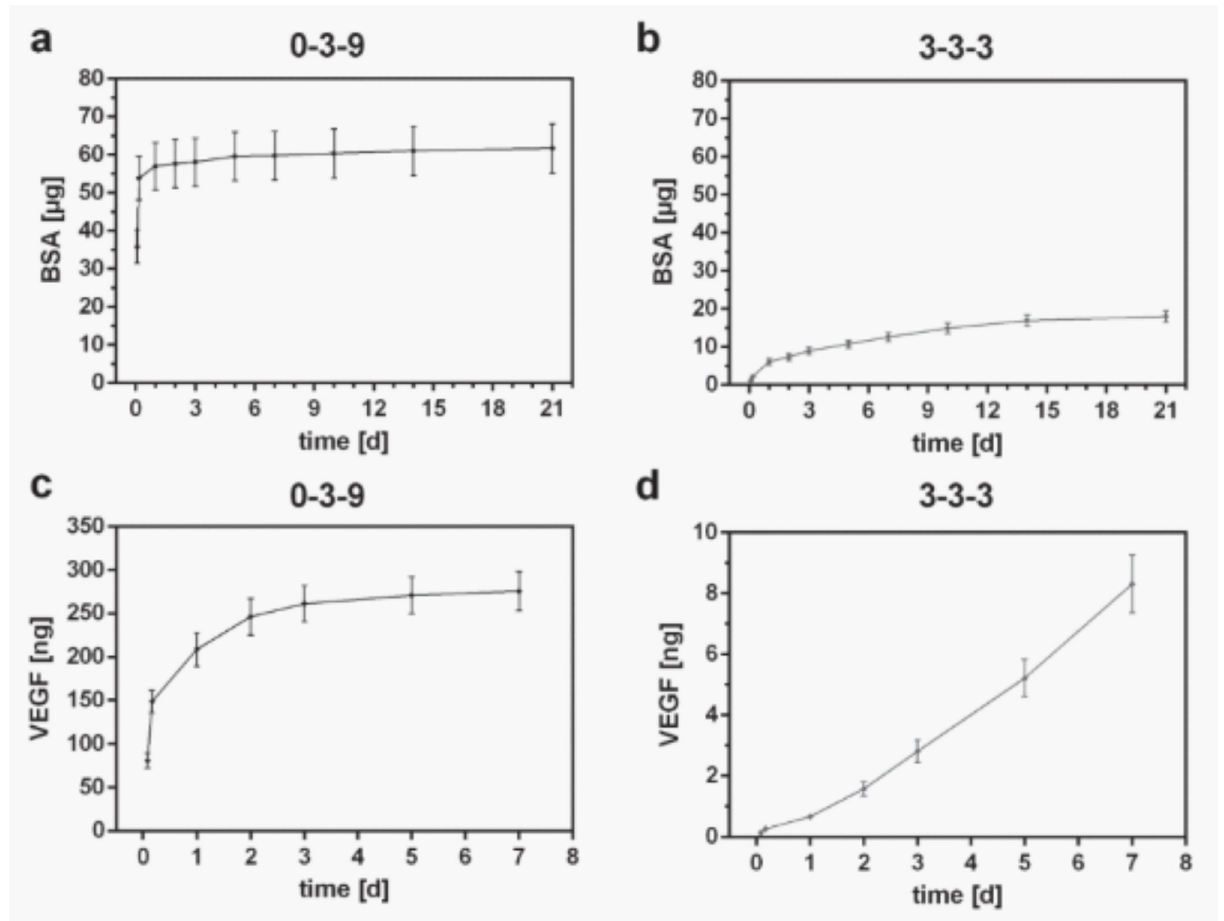
Figure 20. Release of BSA and VEGF proteins from MC/ALG/LAP constructs. The 0–3–9 stands for constructs made of 0% LAP, 3% ALG and 9% MC (wt), while 3–3–3 stands for 3% wt concentration of all the ingredients. Cumulative release curves of BSA ( a , b ) and VEGF ( c , d ). Reproduced with permission from [73], Elsevier,